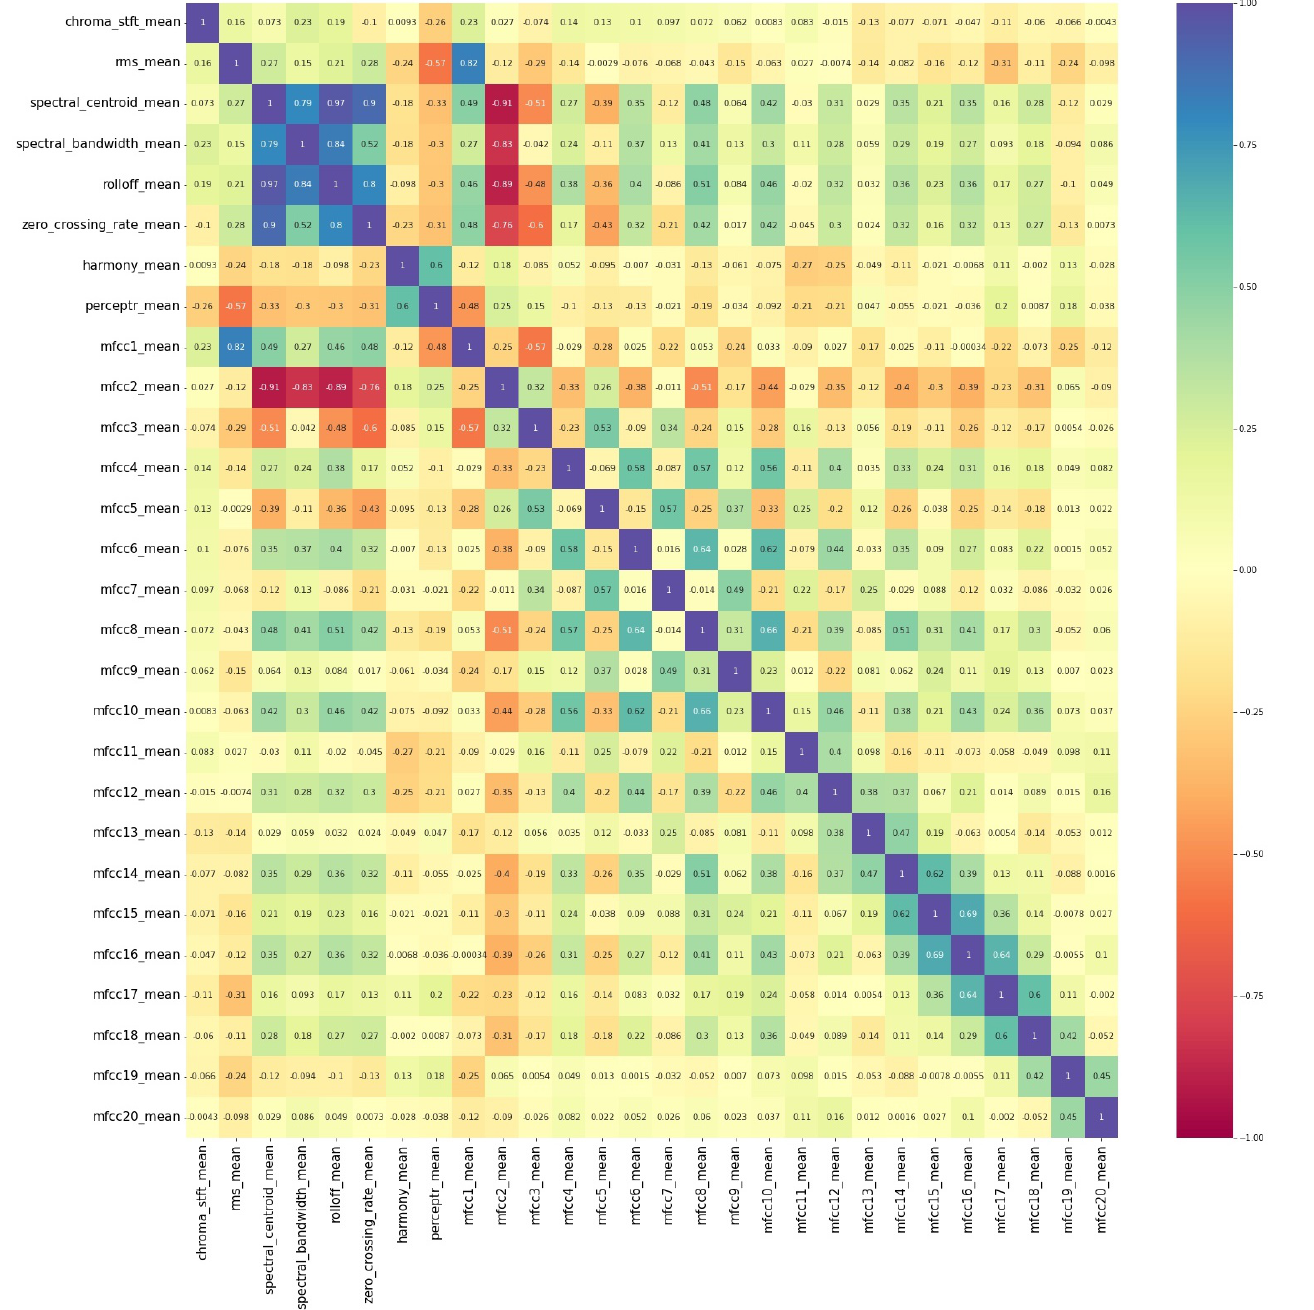
Figure 10. Correlation between means of music features. Figure 11 indicates the correlations between spectral centroid variance, spectral cen- troid mean, spectral bandwidth mean, spectral bandwidth variance, spectral roll-off mean, and spectral roll-off variance with the target variable music classes. The diagonal cells denote perfect positive correlations between the same music features which are highlighted in blue colour on the heat map. Figure 11 also depicts that there are very low or zero correlations between spectral features and the target variable music classes which are highlighted in yellow colour on the heat map. This means that the change in